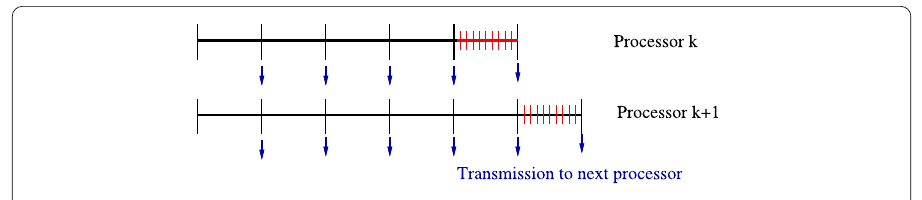
Figure 2 Parareal algorithm with fine/coarse grid in F (cid:2) T -step